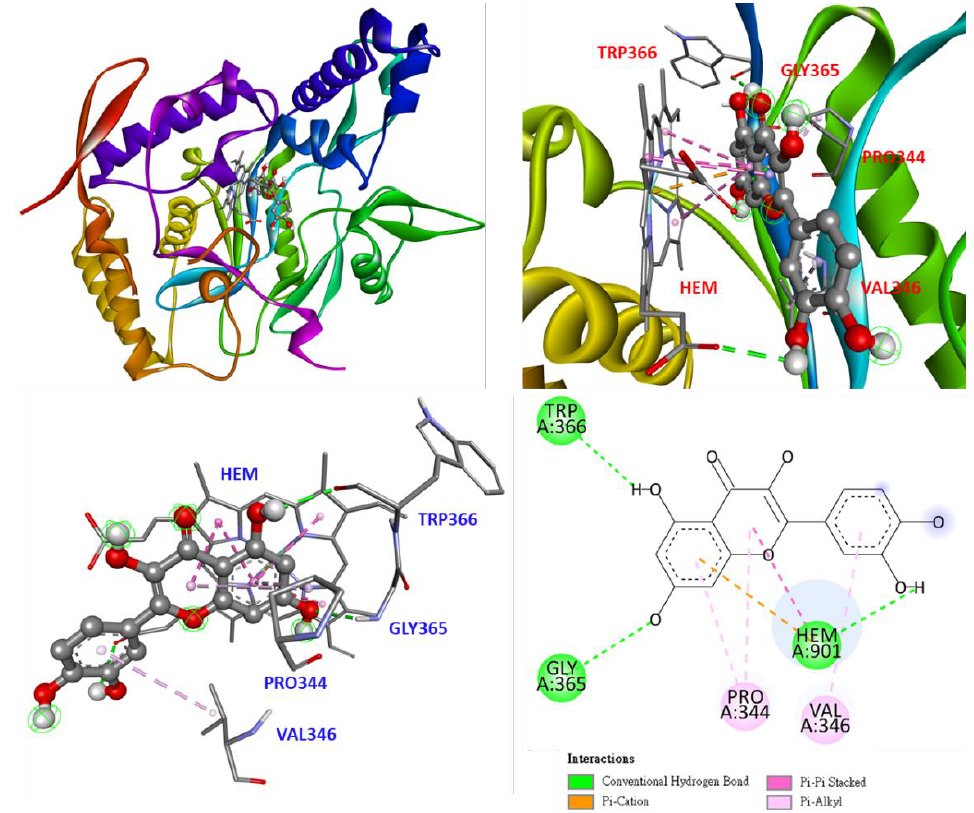
Figure 9. Interaction of morusin ( 2 ) with active sites of Mus musculus iNOS .